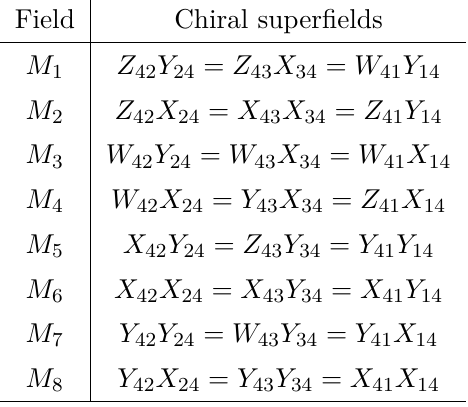
Table 4 . Generators of Q 1 , 1 , 1 in terms of fields in phase